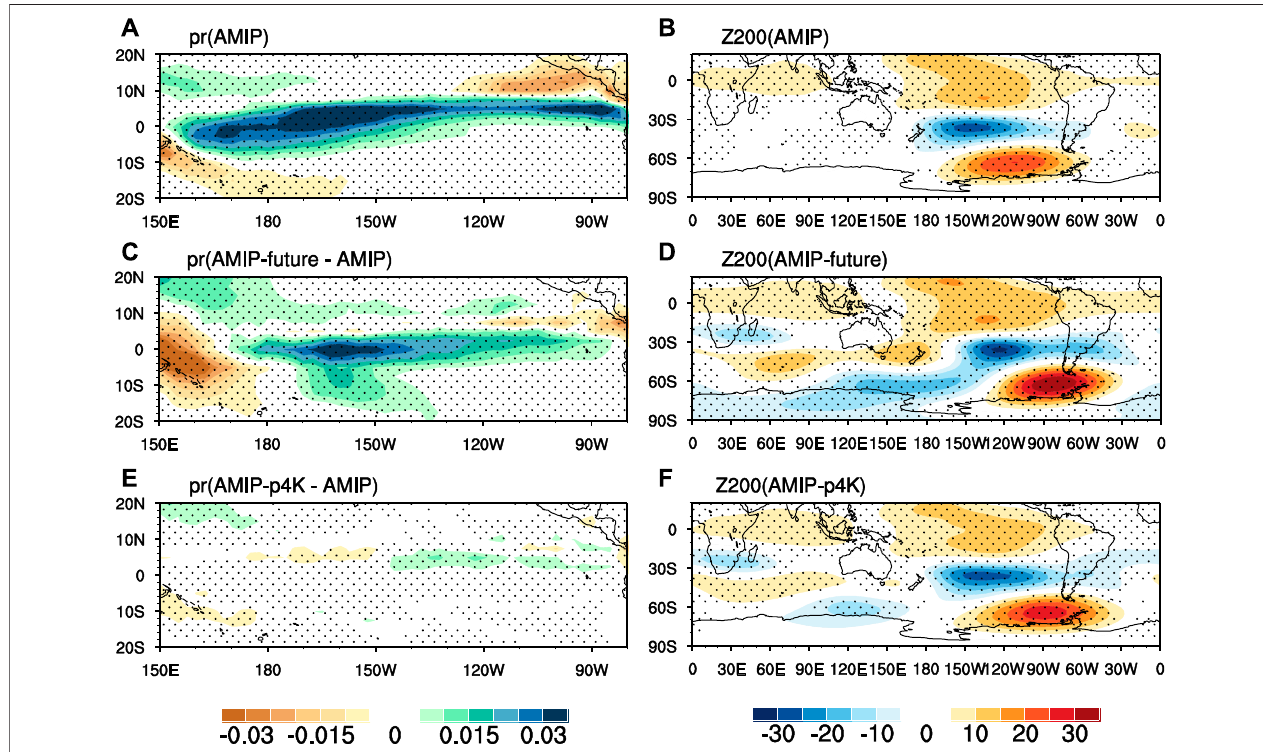
FIGURE2| SimulatedENSO-drivenrainfallanomalies(mm/day,leftcolumn)andENSO-drivengeopotentialheightanomalies(m,rightcolumn)in (A , B) AMIP, (C , D) AMIP-future4K, and (E , F) AMIP-p4K MME. The precipitation anomalies in (C , E) denote the precipitation change compared to AMIP. Stippling denotes that more than 70% of models agree on the sign of the